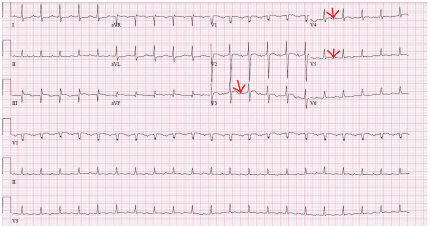
Figure 1: EKG with T-wave inversions in the lateral leads V3–V5 as denoted by arrows.